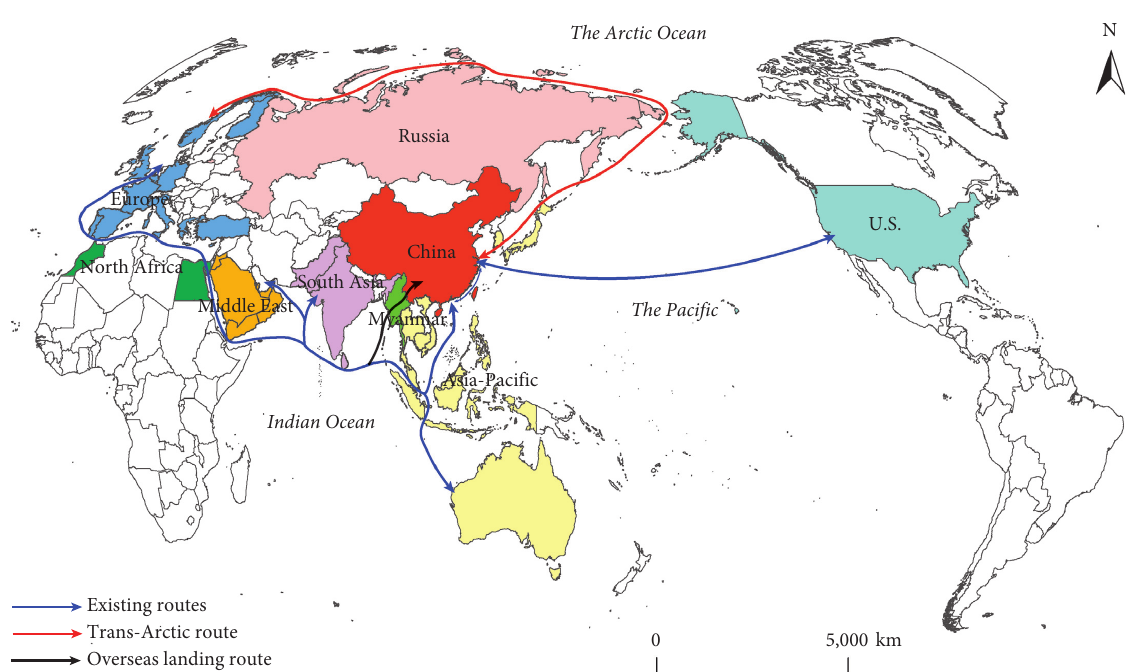
Figure 1: Main routes of the submarine cable network of mainland